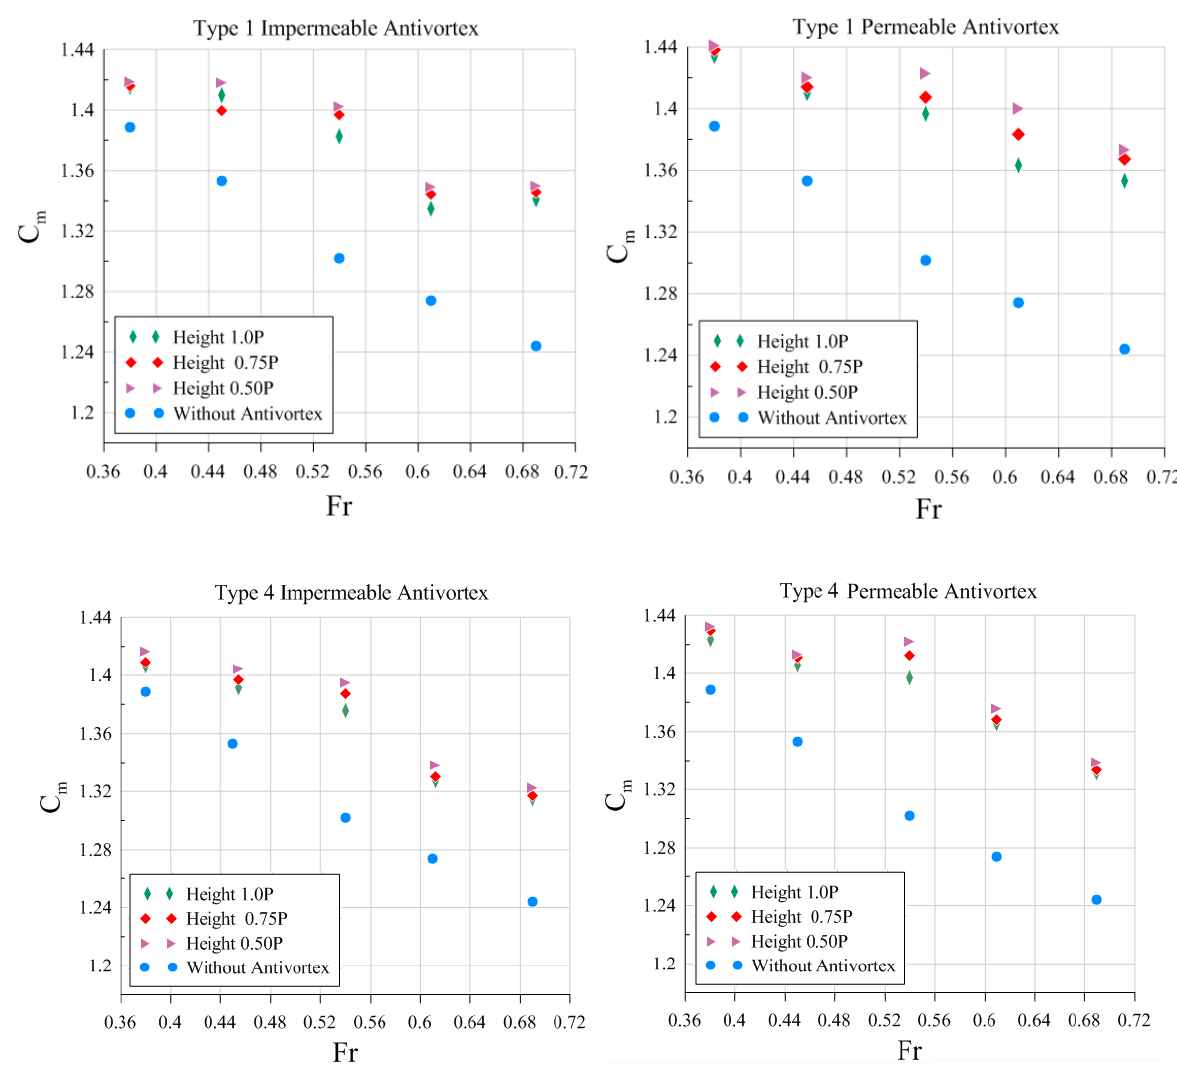
Figure 17. The effect of the antivortex height on the discharge coefficient of the triangular labyrinth side weir.